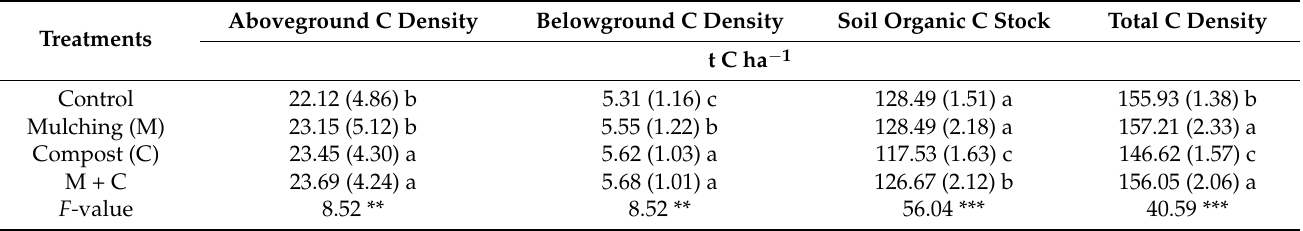
Table 3. Above- and belowground carbon density (t C ha −1 ), soil organic C stock (t C ha −1 ), and total P. pyrifolia C density (t C ha −1 ) among the studied treatments of organic residues management in a subtropical ecosystem, Curitibanos, Santa Catarina, Southern Brazil.